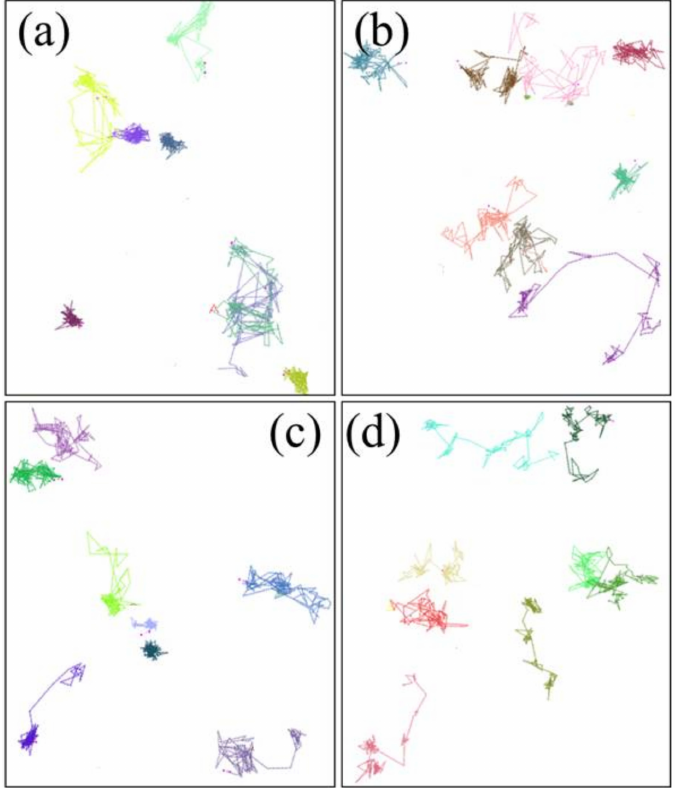
Figure 9. The motion trajectories of the oxygen molecules in the aged NBR models: ( a ) 298.15 K/OH- NBR; ( b ) 383.15 K/OH-NBR; ( c ) 298.15 K/CO-NBR; ( d ) 383.15